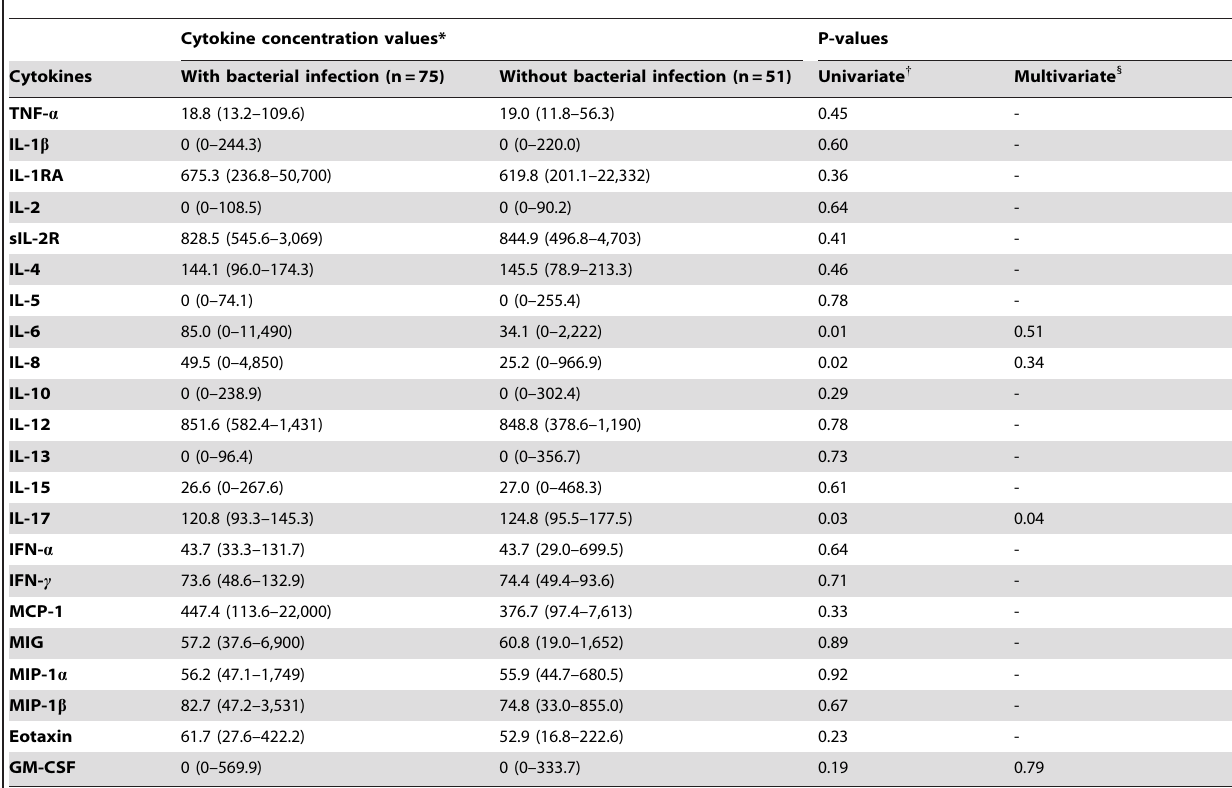
Table 6. Serum concentrations of cytokines in patients with and without bacterial infection.